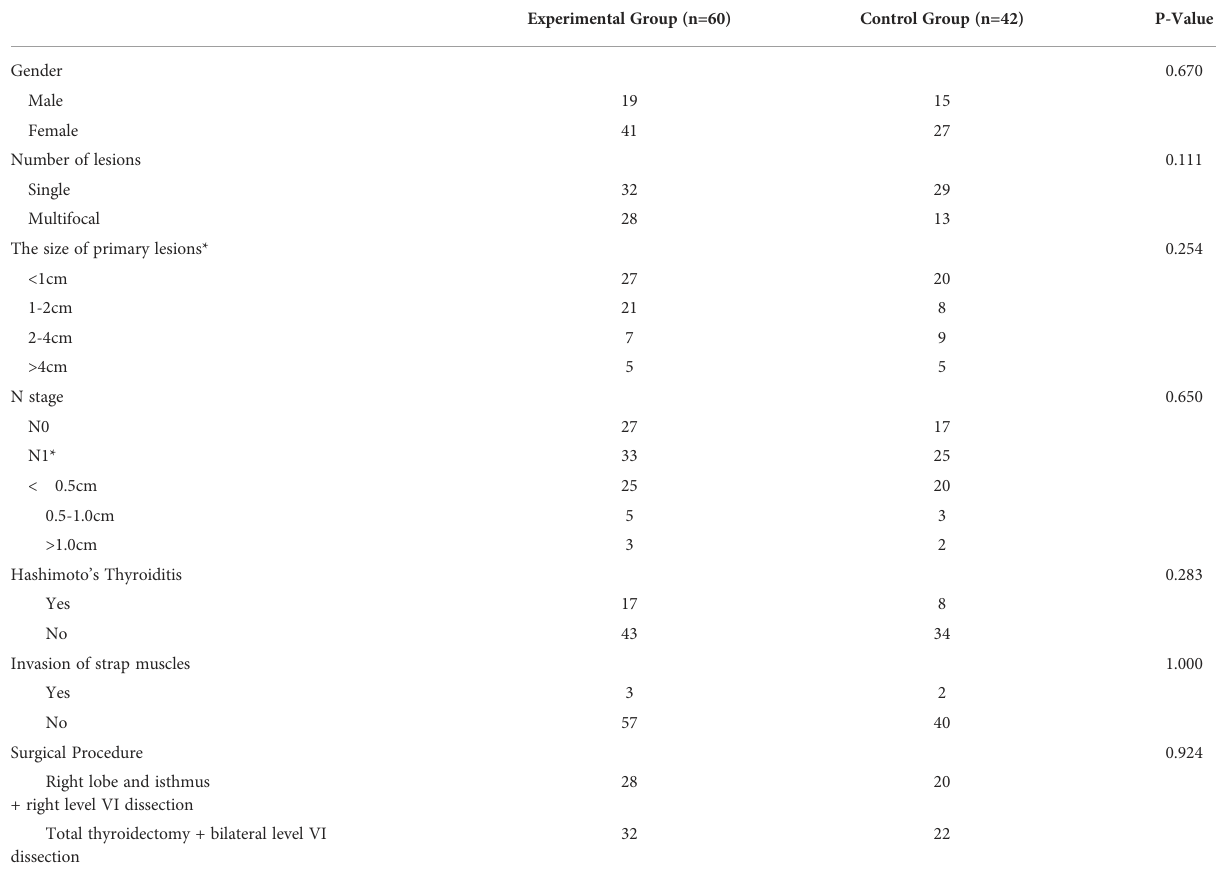
TABLE 2 Patients and disease characteristics between two